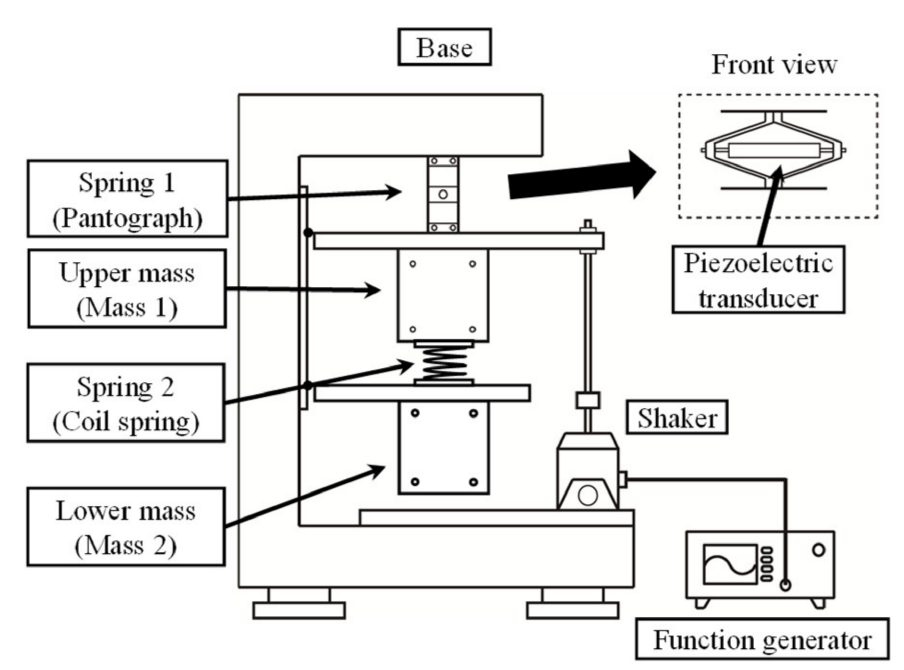
Figure 4. Experimental apparatus for assessment